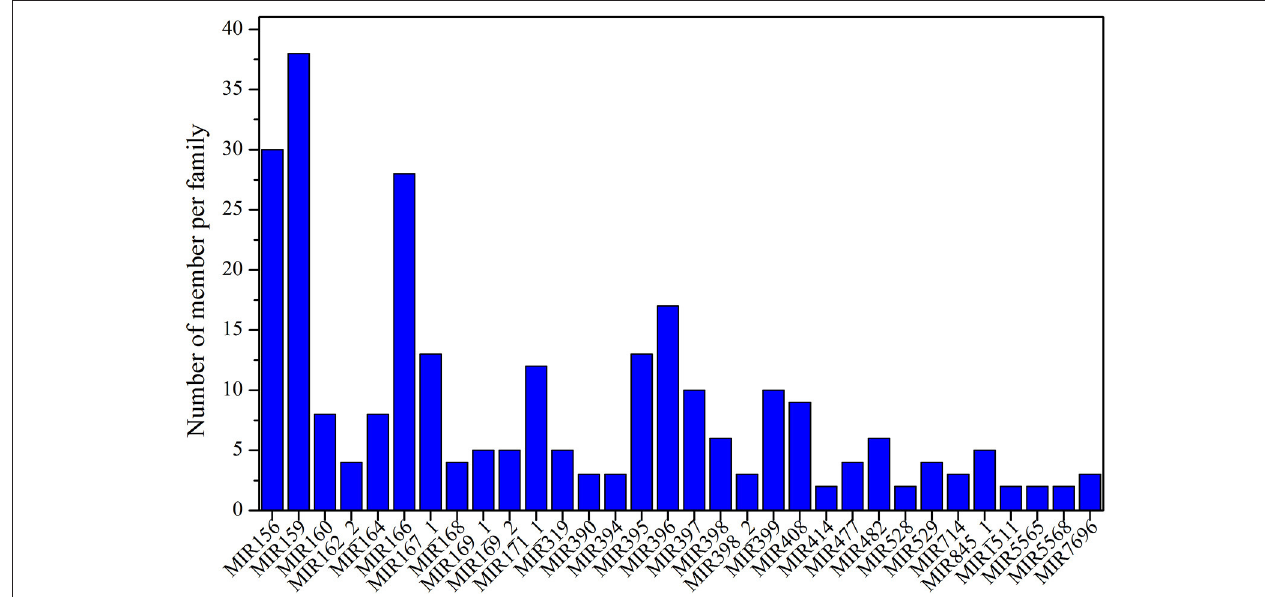
FIGURE 2 | Distribution of known miRNA family sizes in Lilium pumilum DC. Fisch.